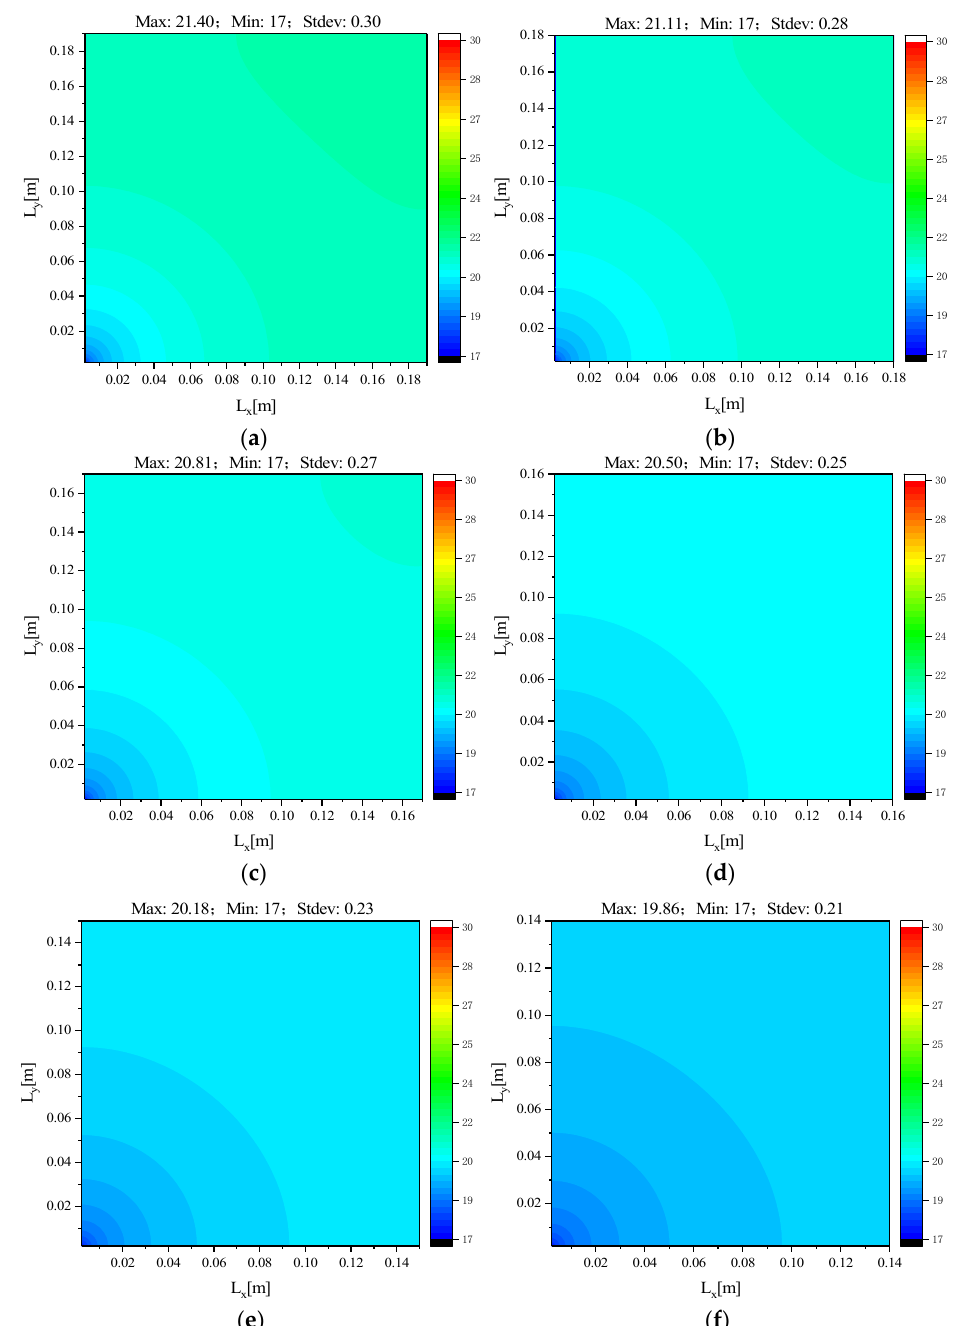
Figure 5. Temperature distribution clouds for thermoelectric radiation panels. ( a ) spacing: 0.38 m. ( b ) spacing: 0.36 m. ( c ) spacing: 0.34 m. ( d ) spacing: 0.32 m. ( e ) spacing: 0.30 m. ( f ) spacing: 0.28 m.